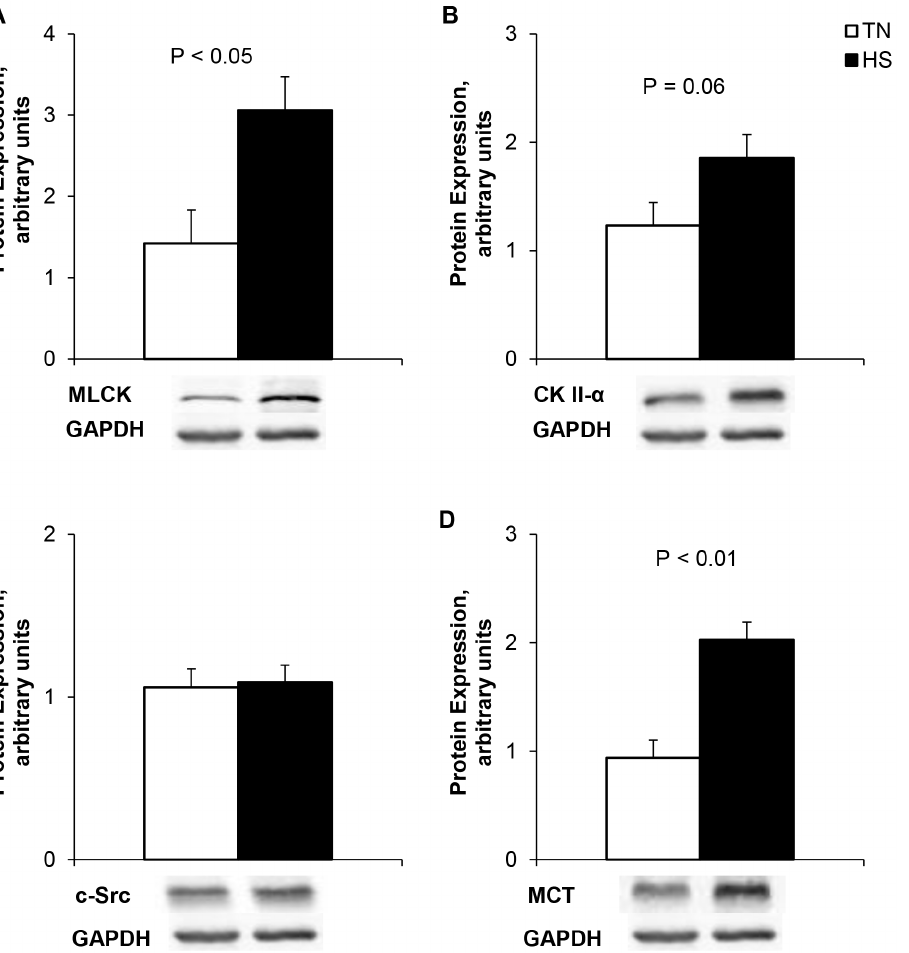
Figure 2. Heat stress augments ileum protein expression of TJ protein regulatory machinery; a) Myosin light chain kinase (MLCK), b) Casein kinase (CK) II- a , c) c-Src, and d) Mast cell tryptase (MCT) in growing pigs. Pigs were exposed for 24 hours to either constant thermal neutral conditions (TN; 21 u C) or heat stress conditions (HS; 35 u C). n=8/trt.